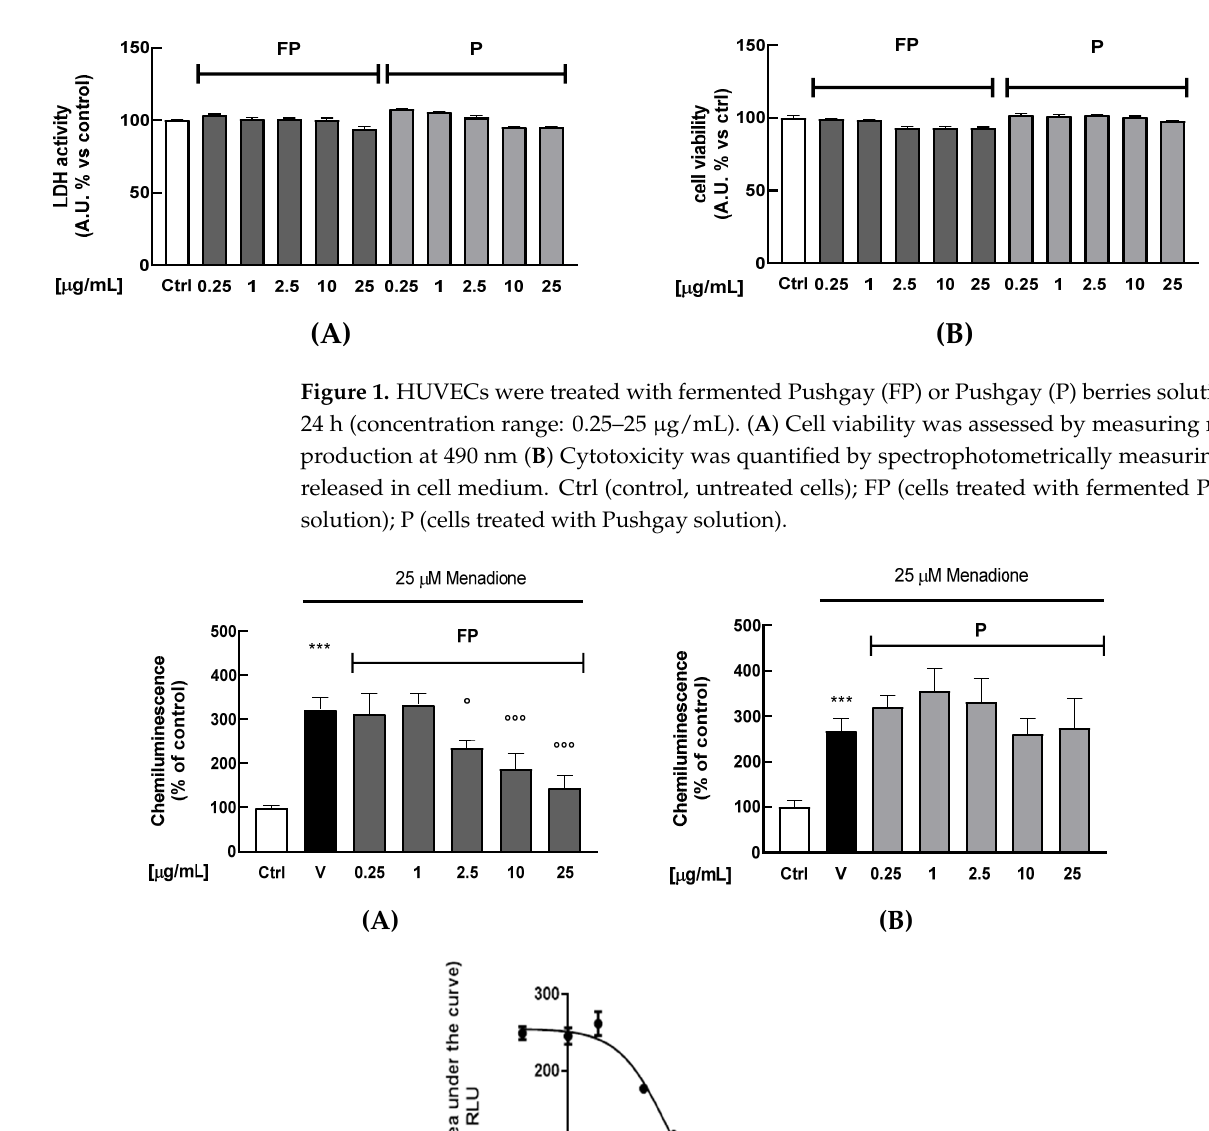
Figure 1 . HUVECs were treated with fermented Pushgay (FP) or Pushgay (P) berries solutions for 24 h (concentration range: 0.25–25 µg/mL). ( A ) Cell viability was assessed by measuring red dye production at 490 nm ( B ) Cytotoxicity was quantified by spectrophotometrically measuring LDH released in cell medium. Ctrl (control, untreated cells); FP (cells treated with fermented Pushgay solution); P (cells treated with Pushgay solution).